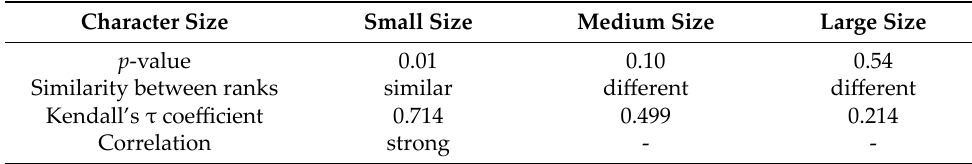
Table 13. Verification of the influence ranking of character elements by character size using Kendall’s Tau correlation